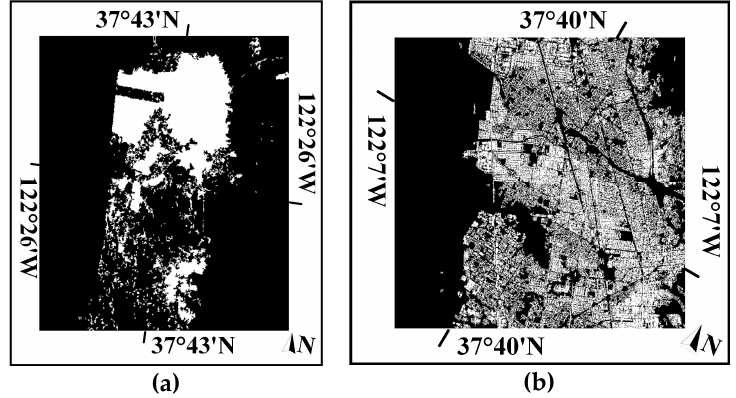
Figure 5. Extraction results using the scattering feature. ( a ) GF-3 data. ( b ) UAVSAR data.